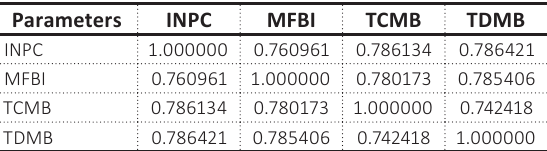
Table 10. Short-run dynamic estimates of